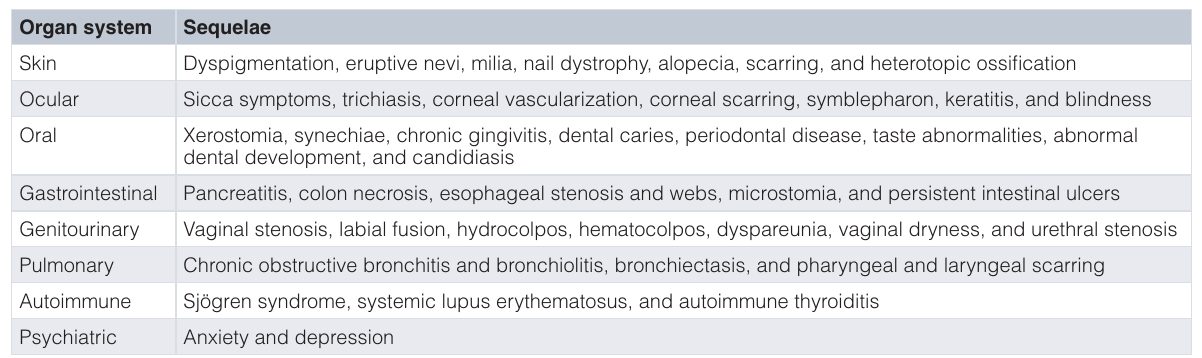
Table 5. Potential chronic sequelae of Stevens–Johnson syndrome – toxic epidermal necrolysis. Organ